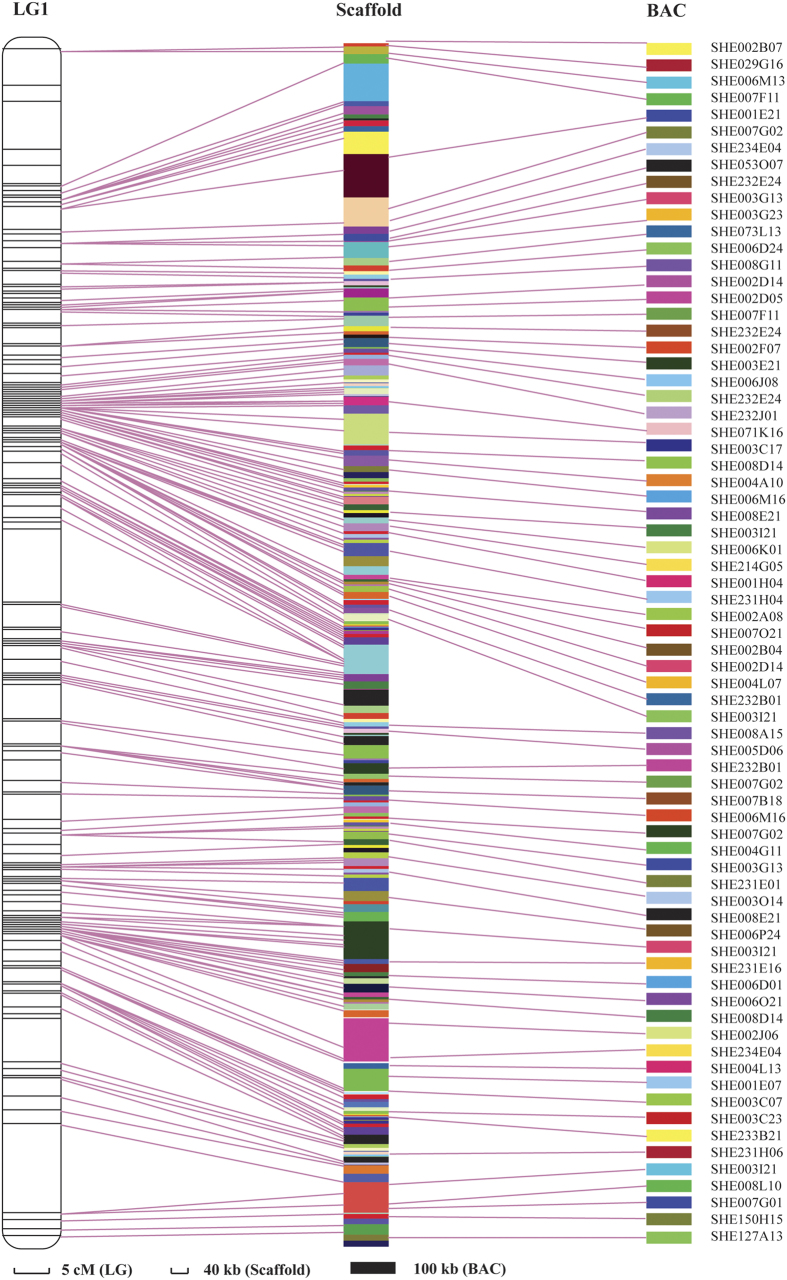
Demonstration of the integration of linkage group LG1, genomic scaffolds and BAC clones.